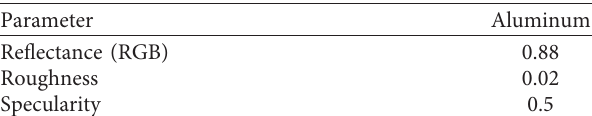
Table 6: Material information of louvers.